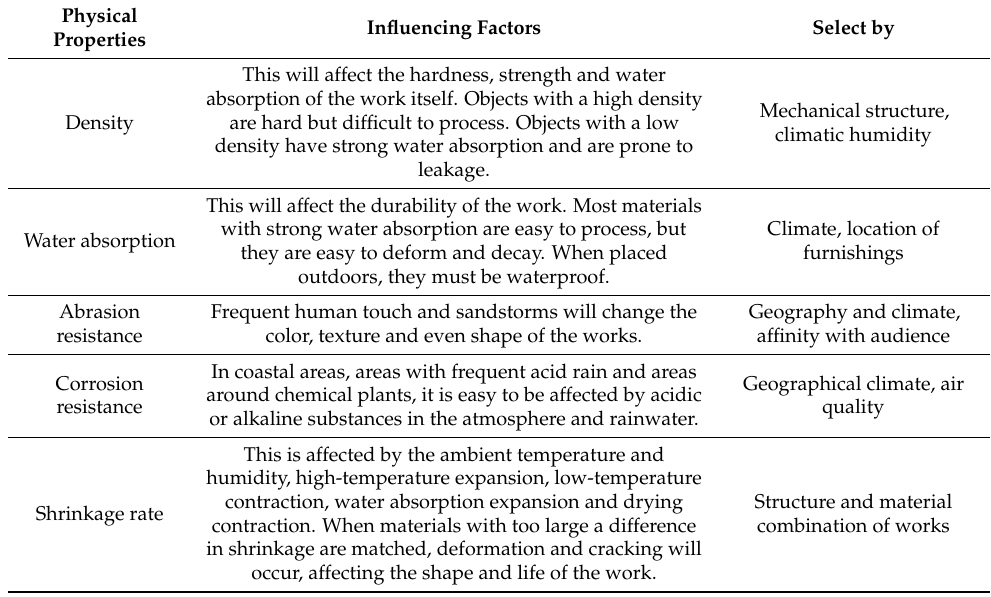
Table 3. Requirements for physical properties of public art materials